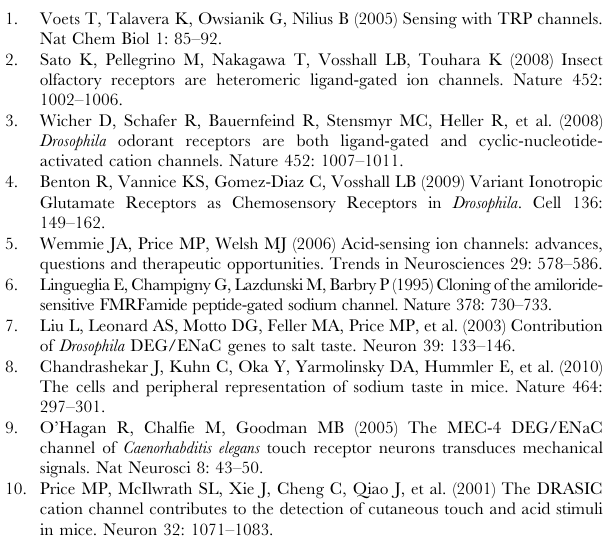
Table S1 List of real-time q-RT-PCR